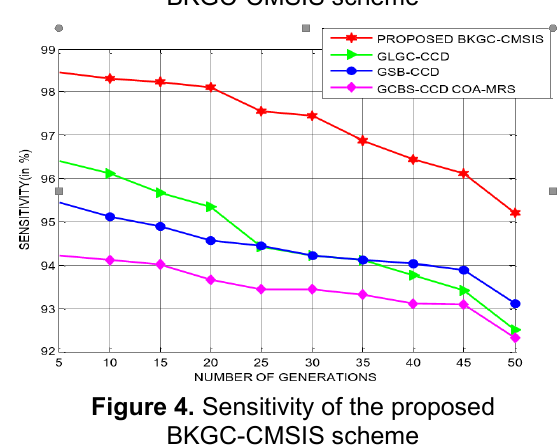
Figure 4. Sensitivity of the proposed BKGC-CMSIS scheme